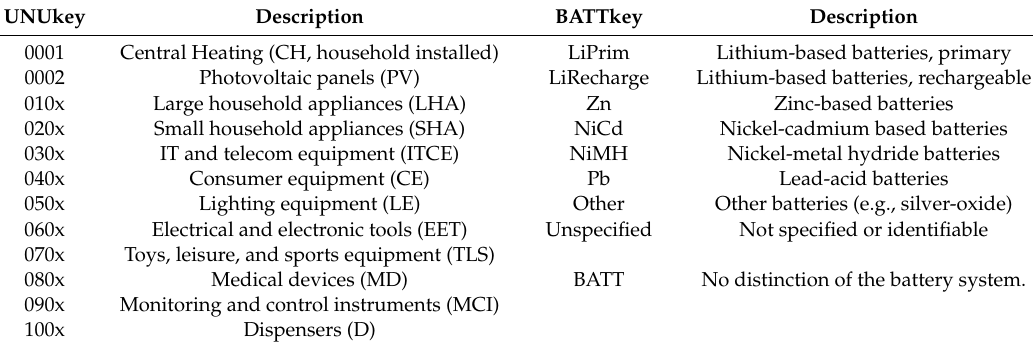
Table 1. Classification of waste electrical and electronic equipment (WEEE) categories (UNUkey main structure, the detailed classification can be found in Supplementary Materials Tables S16 and S17) and battery systems (BATT